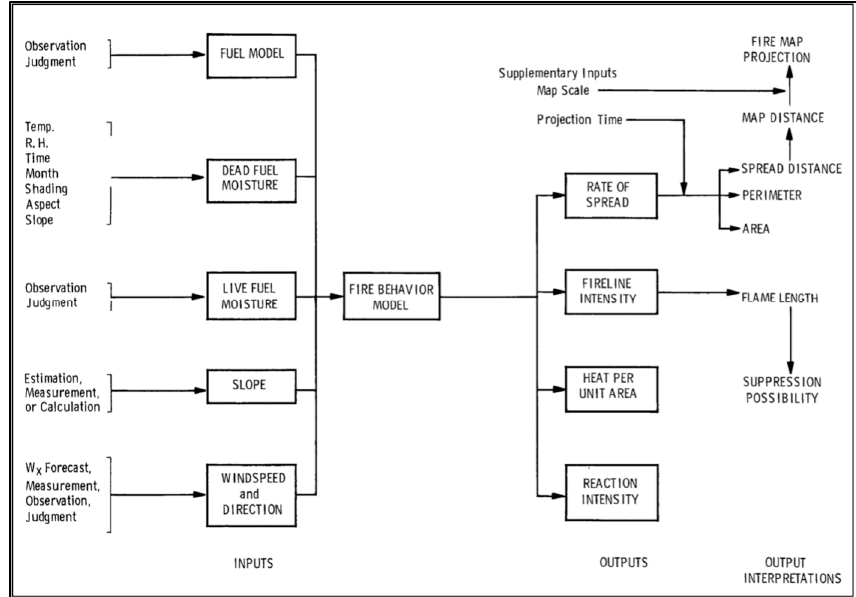
Figure 1. Inputs for the NFDRS fire behavior model. Note the presence of RH, live and dead fuel moistures (ERC; RH), and wind speed. With the exception of temperature, all other variables included in the NFDRS model are either site-specific or time related. Adapted from How to Predict the Spread and Intensity of Forest and Range Fires (INT-143) [33] (p. 2), Intermountain Forest and Range Experiment Station: Ogden, UT: USDA Forest Service. Retrieved from https://www.fs.fed.us/rm/pubs_int/int_gtr143 accessed 18 March 2023. In the public domain.